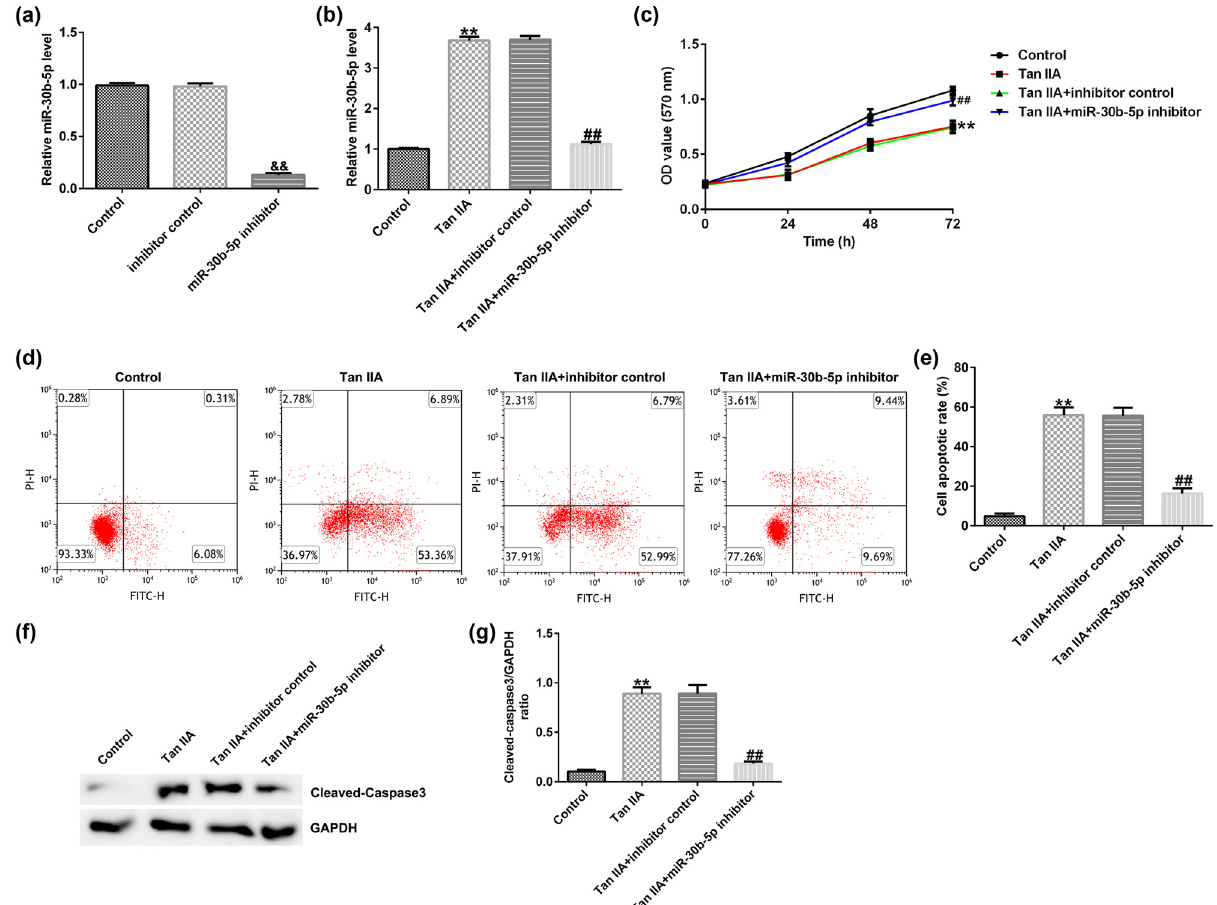
Figure 7: Downregulation of miR - 30b - 5p reverses the inhibition of SW480/R cells induced by Tan IIA. ( a ) The e ffi ciency of miR - 30b - 5p inhibitor was veri fi ed by RT - qPCR assay. ( b ) RT - qPCR assay was conducted to appraise the level of miR - 30b - 5p in SW480/R cells following Tan IIA ( 16 μ M ) treatment for 48 h. ( c ) MTT assay was carried to assess SW480/R cells viability. ( d and e ) FCM assay was carried out to measure SW480/R cells ’ apoptosis. ( f ) Western blot was used to quantify the expression levels of apoptosis - related protein ( cleaved - caspase3 ) . ( g ) The ratio of cleaved - caspase3/GAPDH. Data are represented as the mean value ± SD of three independent experiments. ** P < 0.01 vs Control group; ## P < 0.01 vs Tan IIA + inhibitor control group; && P < 0.01 vs Inhibitor control